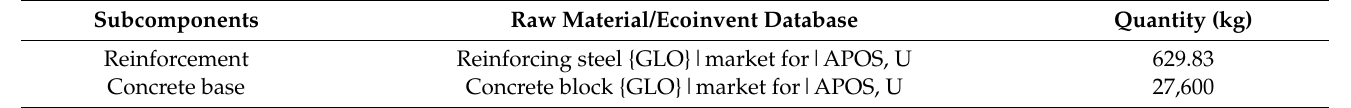
Table A5. Foundation inventory and matching Ecoinvent records.